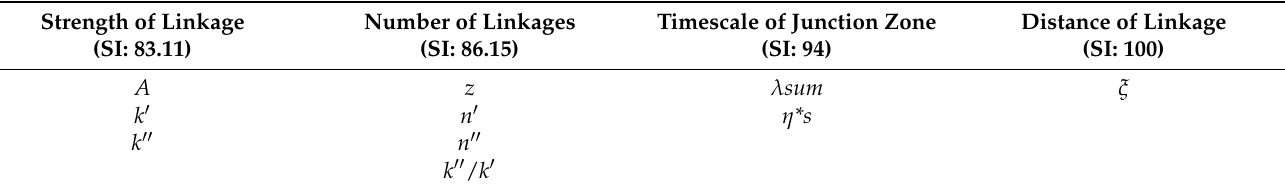
Table 2. Clustering of cheese rheological parameters.